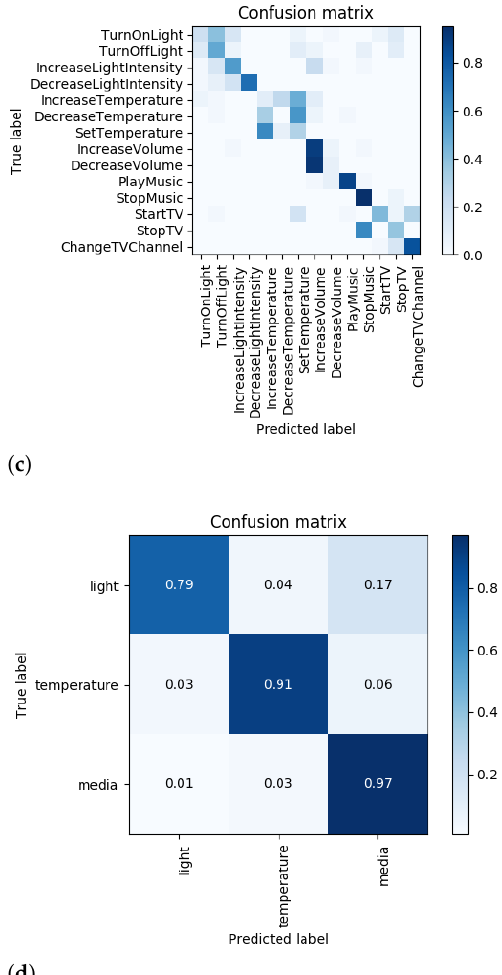
Figure 5. Intent confusion matrices ( a ) Scenario 1 ( b ) Scenario 1 Super-class confusion ( c )